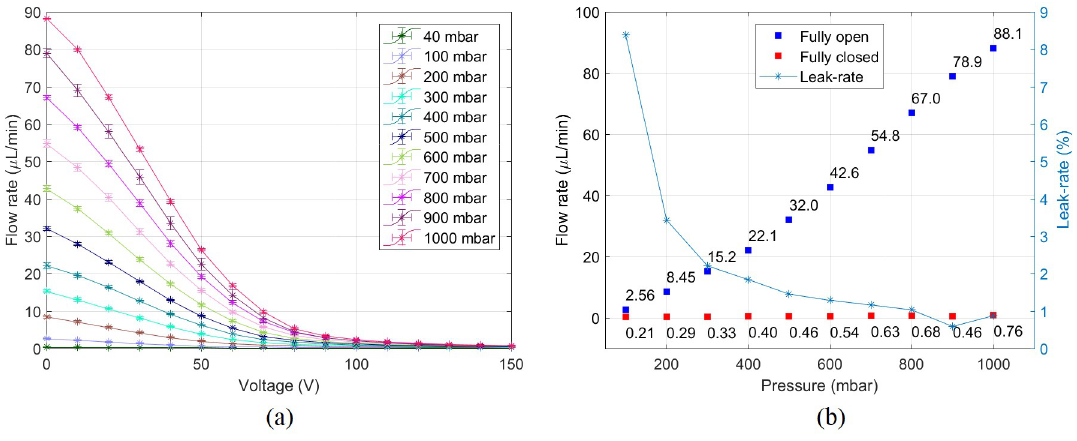
Figure 9. ( a ) Proportional control of flow rate at different pressures. Error bars indicate one standard-deviation of three measurements. ( b ) On-off behaviour and leak-rate of the microvalve at different pressures. Leak-rate is the ratio of closed and open flow rates.